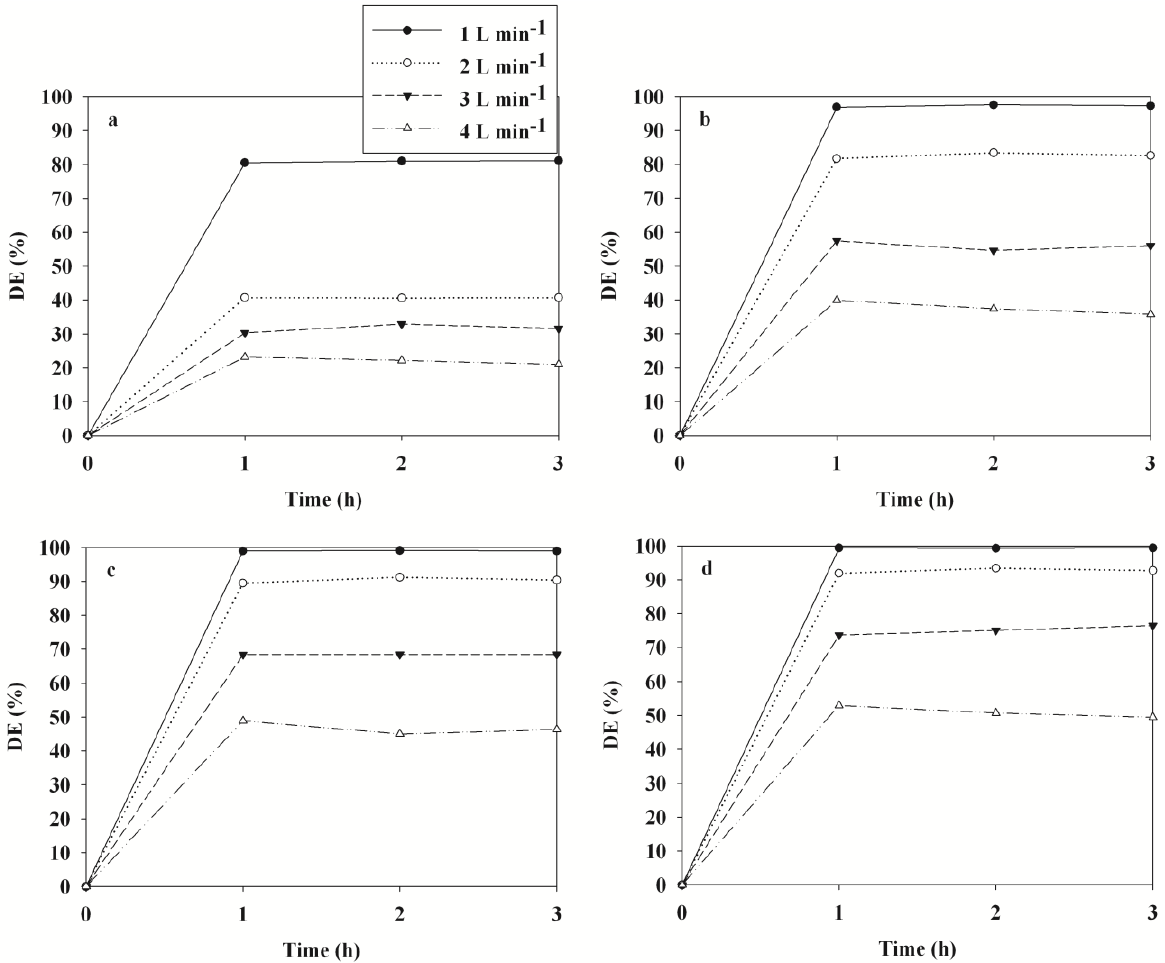
Figure 6. Degradation efficiencies (DE) of ( a ) benzene; ( b ) toluene; ( c ) ethyl benzene; ( d ) o-xylene as determined using TNTUCF-10 according to various air flow rates (1, 2, 3, and 4 L·min −1